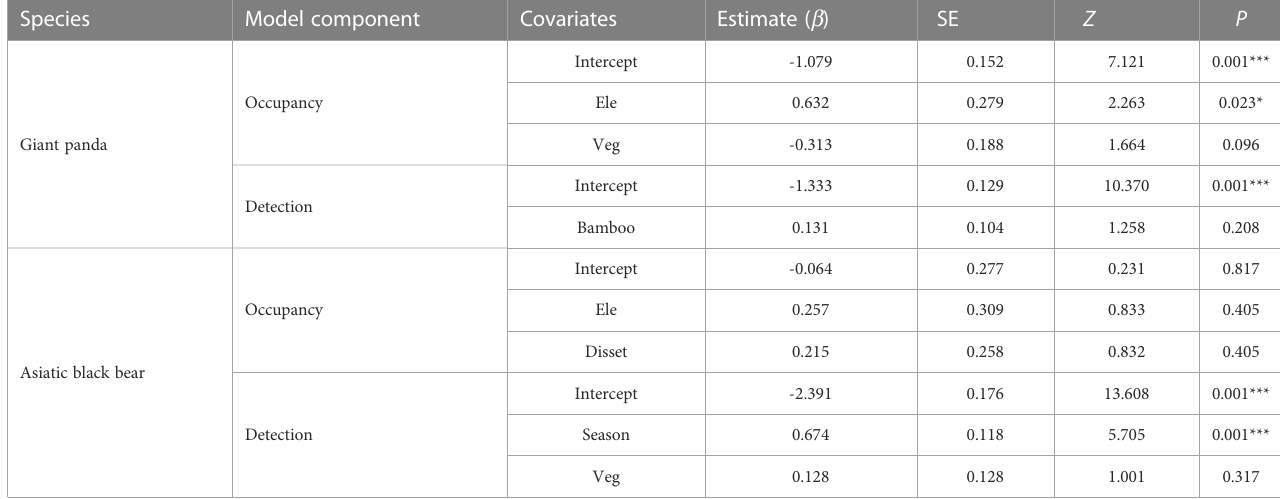
TABLE 2 Estimated parameter coef fi cients ( b ) for covariates in fl uencing giant panda and Asiatic black bear occupancy and detection probability, based on the optimal models ( D AIC ≤ 2). Species